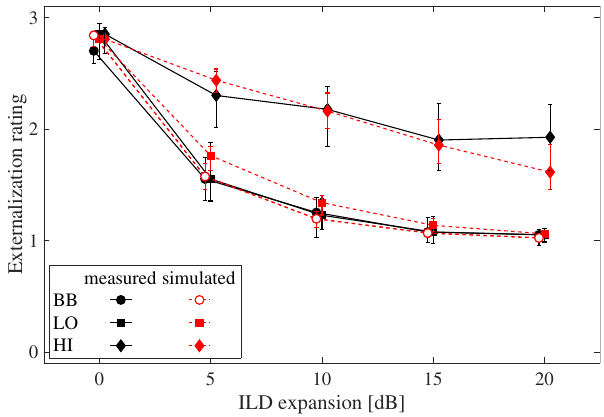
Figure 2. Median values of externalization ratings (solid lines) and model simulations (dashed lines, open and fi lled symbols for mapped and predicted results, respectively) with 95% con fi dence intervals (CIs) for ILD expansions in three different frequency ranges ( “ BB ” , “ LO ” and “ HI ”